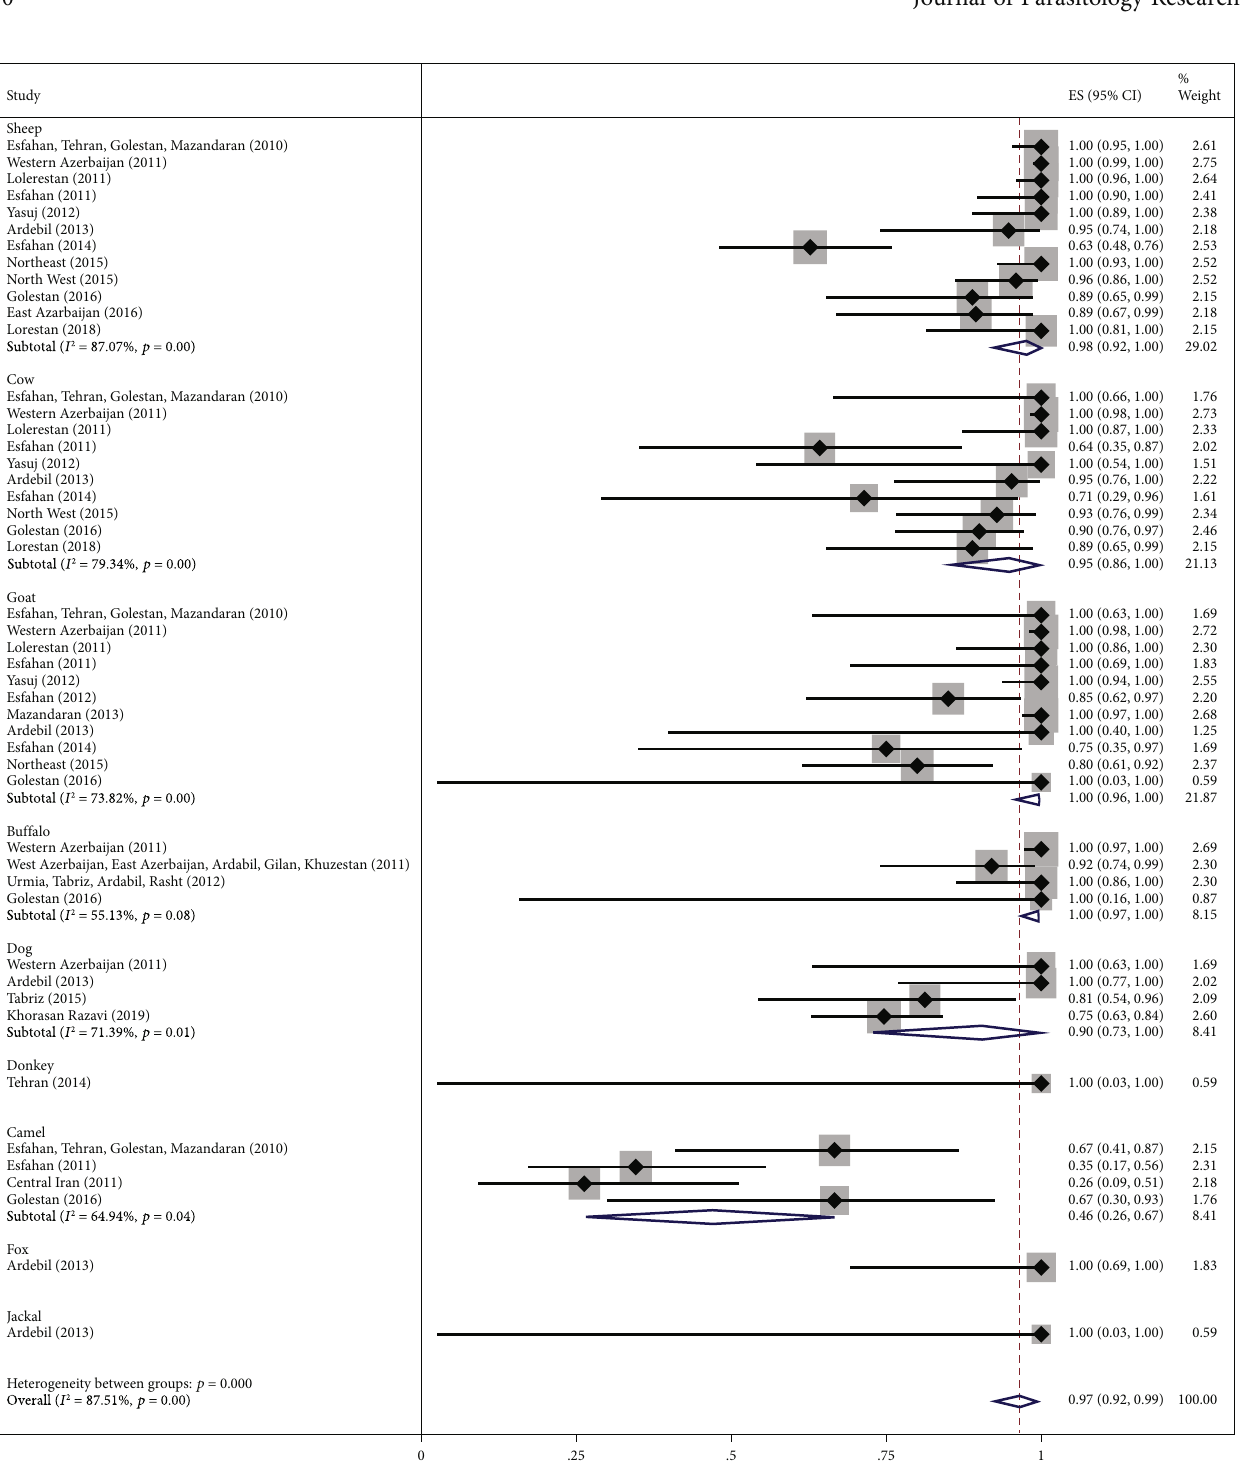
genotype prevalence by animal 1